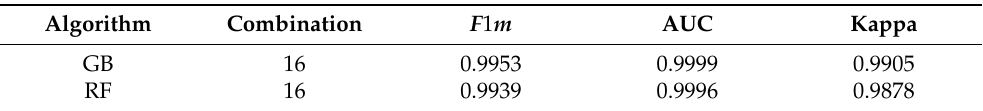
Table 10. Indicators of the performance of algorithms obtained from the confusion matrix for the rainy season.